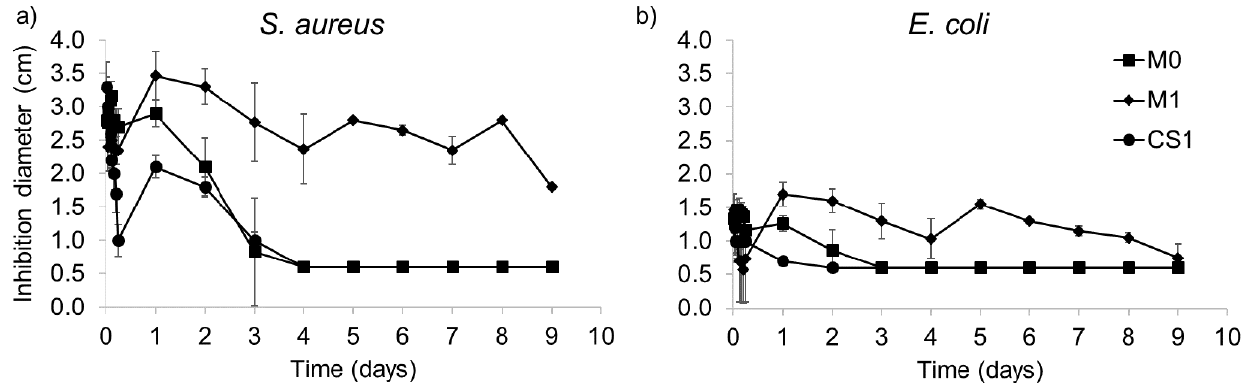
Figure 6. Antibacterial activity against ( a ) S. aureus and ( b ) E. coli of the released medium in PBS from TCL loaded monolithic and core-sheath nanofibers.